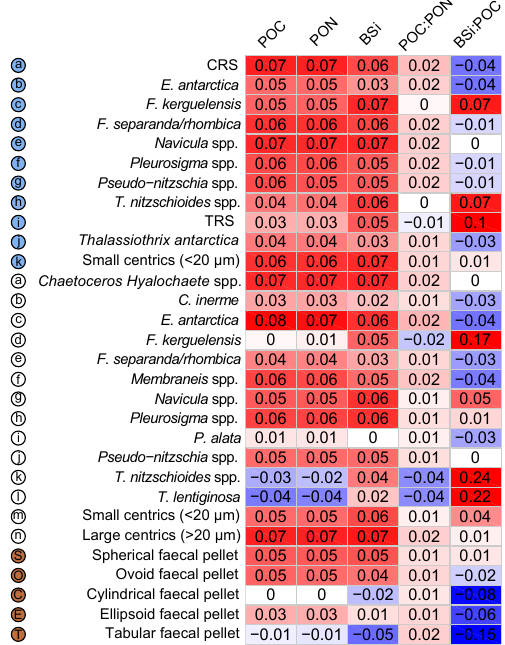
Figure 6. Heat map representation of β correlation coefficients be- tween the biological variables (empty and full cell diatom and fae- cal pellet type fluxes) and the chemical variables (POC, PON, BSi, POC:PON and BSi:POC) resulting from the partial least-squares regression. Blue circles represent full diatom cells, and white cir- cles are empty diatom cells. Brown circles represent the faecal pel- let type fluxes. The alphabetical labels within the circles are used to identify the variable projections shown in Fig. 7. CRS: Chaetoceros Hyalochaete resting spores; TRS: Thalassiosira antarctica resting